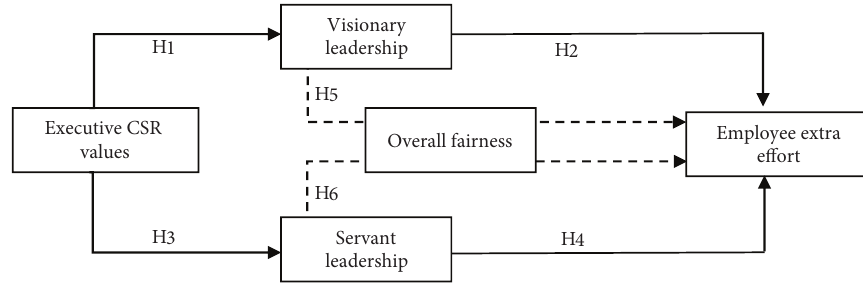
Figure 1. The conceptual model. The dotted line represents the mediated paths (H5 and